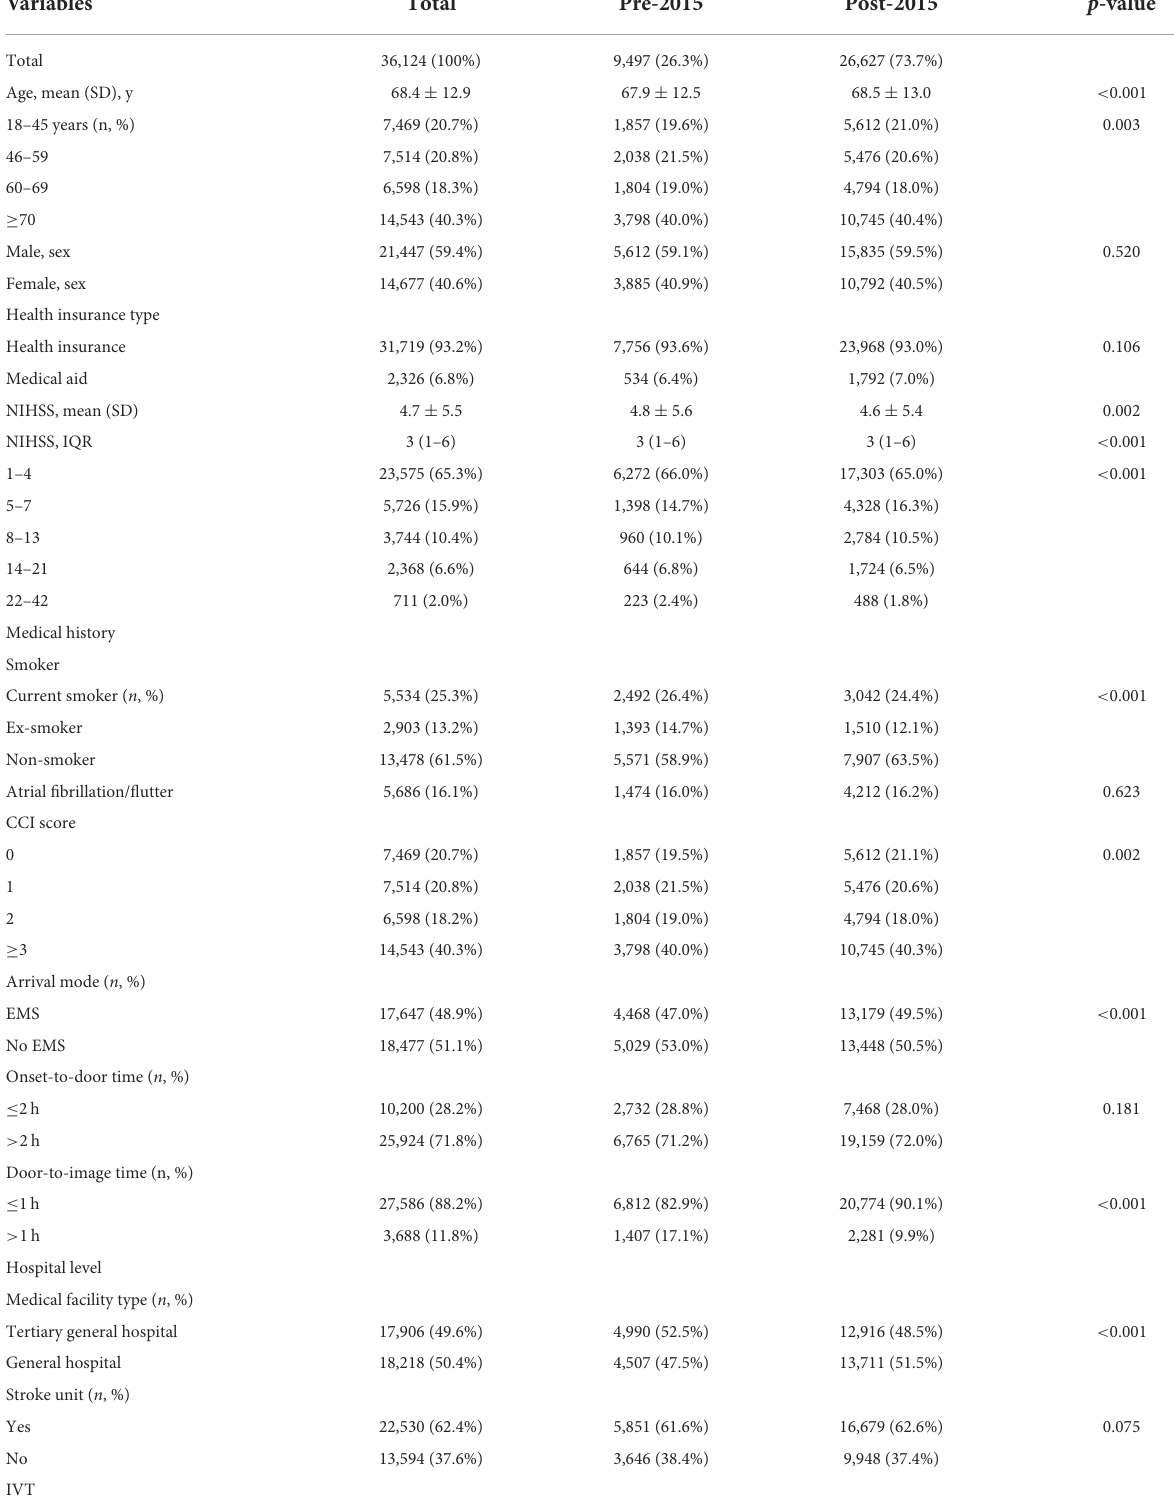
TABLE 1 Baseline characteristics of 36,124 patients with acute ischemic stroke between pre-2015 and post-2015